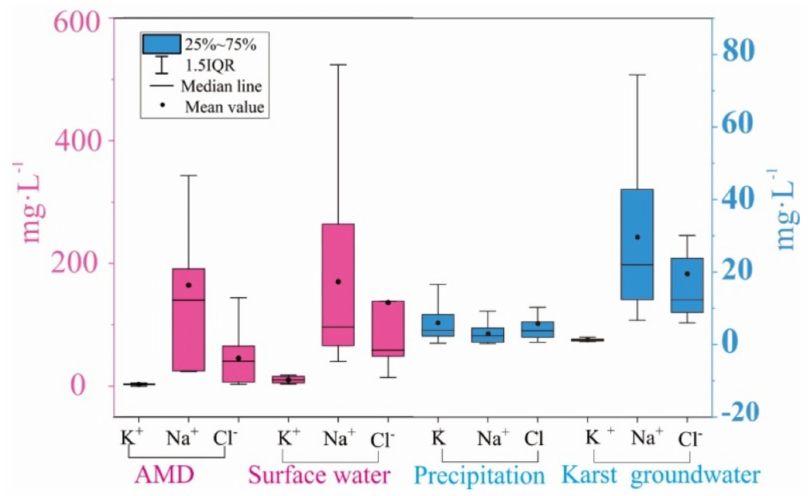
Figure 8. Box chart of K + , Na + , and Cl −